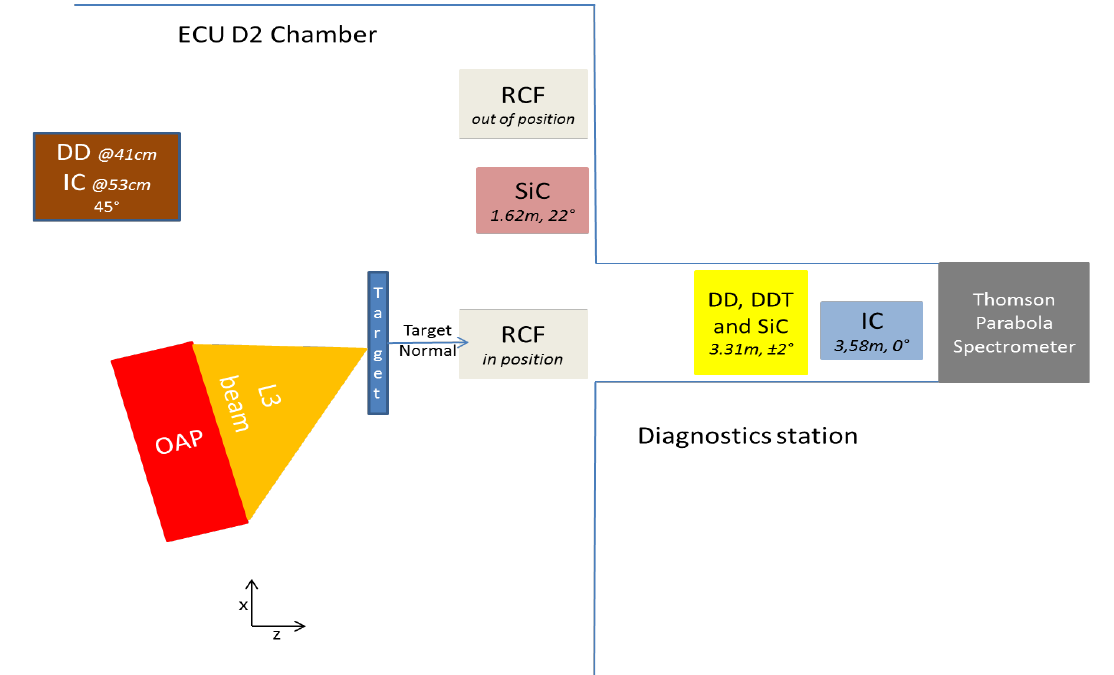
Figure 19. Typical setup for the ion diagnostics around the interaction point.